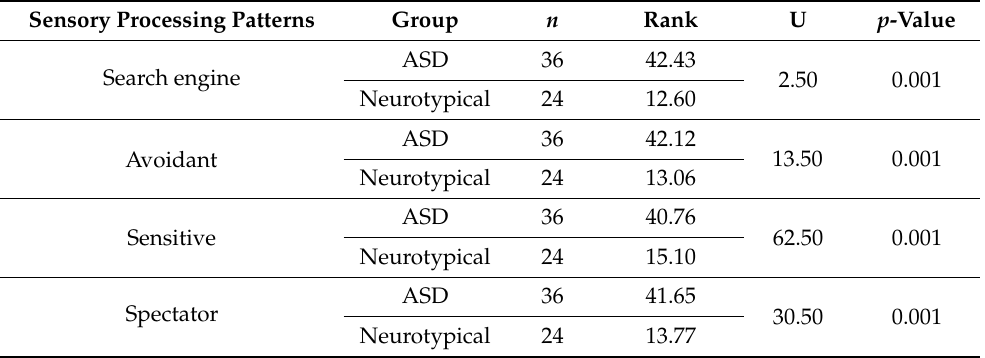
Table 1. Comparison of the scores obtained by children with ASD and neurotypical children in the category “sensory processing patterns”.